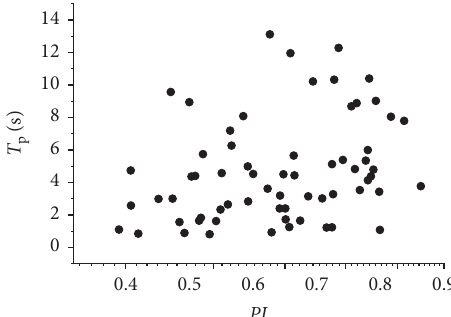
Figure 10: Scatter plot of the pulse period T